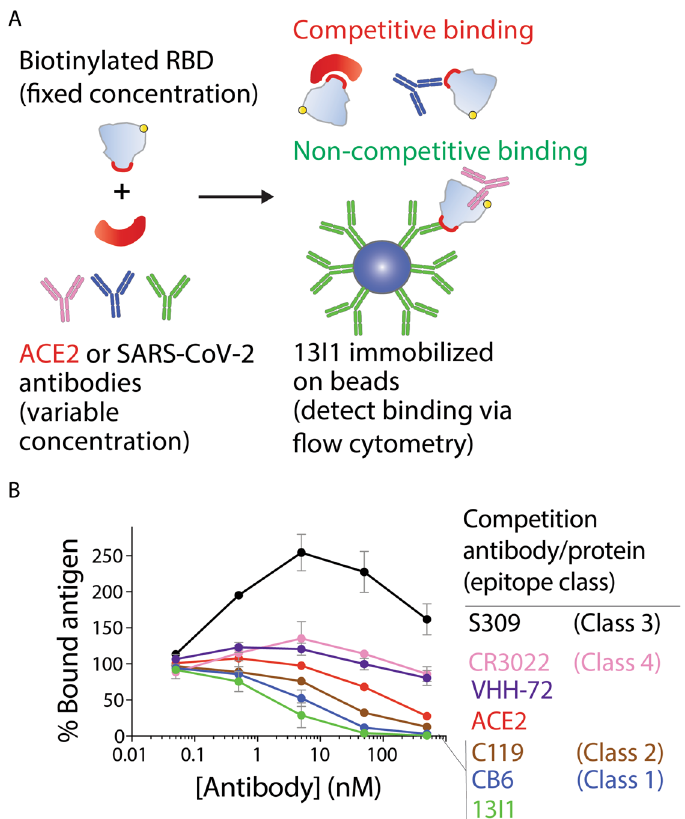
Figure 6. Neutralizing antibody 13I1 competes with ACE2 for binding to the SARS-CoV-2 receptor-binding domain. ( A ) Schematic of competition analysis between 13I1, ACE2 and other antibodies (CR3022, CB6, VHH- 72, C119, S309). Competitive binding analysis was employed in which 13I1, reference antibodies or ACE2 was pre-incubated with biotinylated RBD (5 nM) over a range of concentrations of antibodies or ACE2, and then co-incubated with immobilized 13I1 on Protein A magnetic beads. ( B ) The percentage of SARS-CoV-2 RBD bound is reported relative to the amount bound in the absence of pre-blocking with antibodies or ACE2. The results are averages from two independent experiments and the error bars are standard